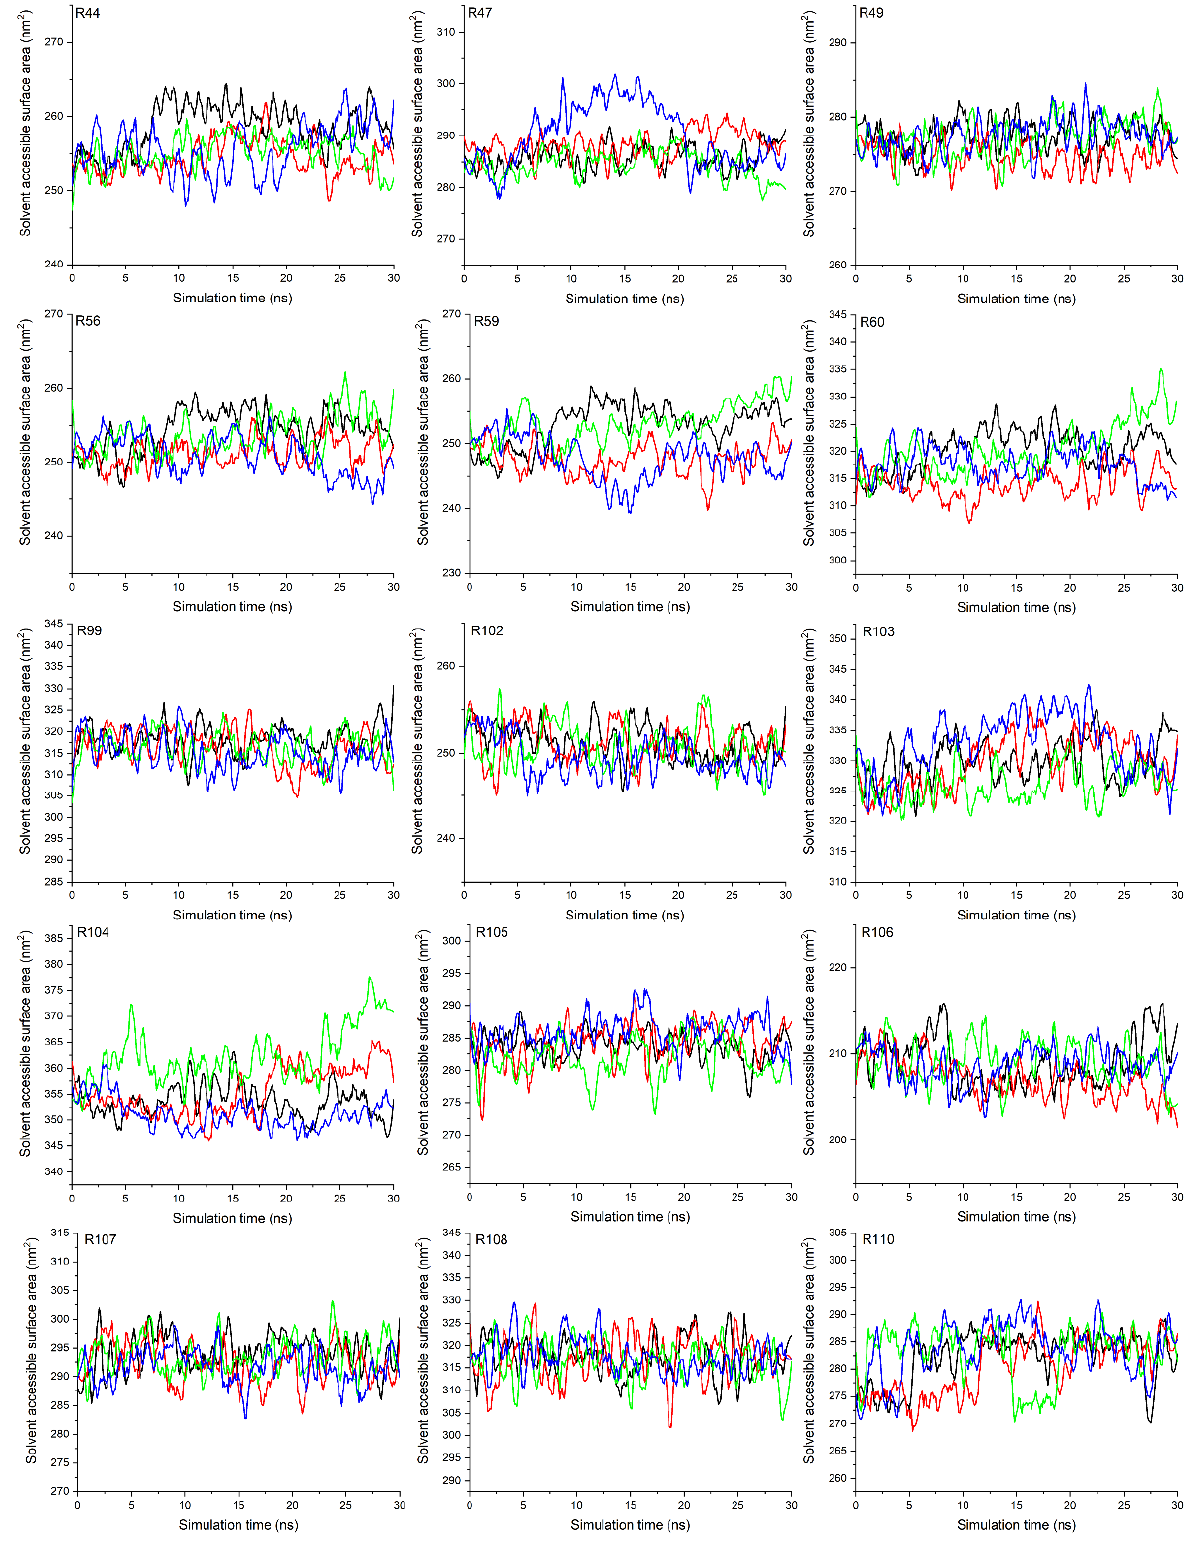
Figure 2. The solvent access area of α-lactalbumin residues in the binding site under different thermal treatments (letter R refers to the residues of α-Lactalbumin).